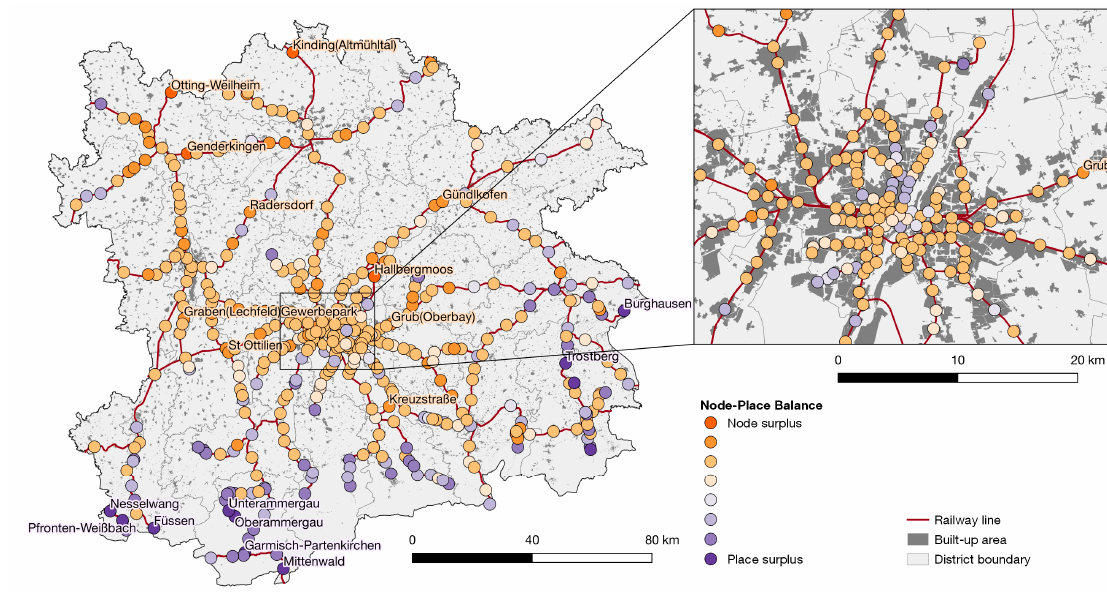
Figure 7. Balance of accessibility (“Node”) and functional density (“Place”) around railway stations in the MMR in 2019 (Source: own work, using geodata by Bayerische Vermessungsverwaltung, Bundesamt für Kartographie und Geodäsie, Deutsche Bahn).